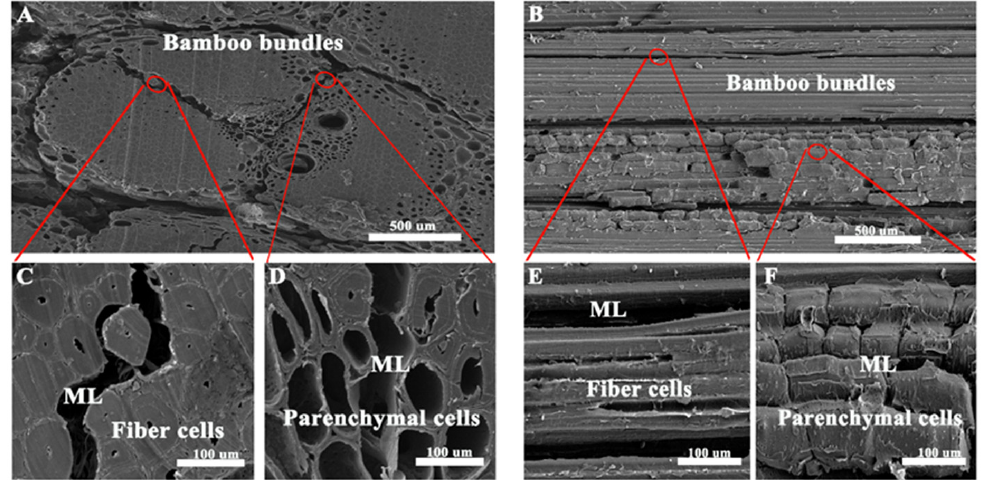
Figure 3. SEM microscope images of bamboo bundles. ( A , C , D ) Vascular bundles, fiber cells and parenchymal cells in a radial section; ( B , E , F ) vascular bundles, fiber cells and parenchymal cells in a longitudinal section.